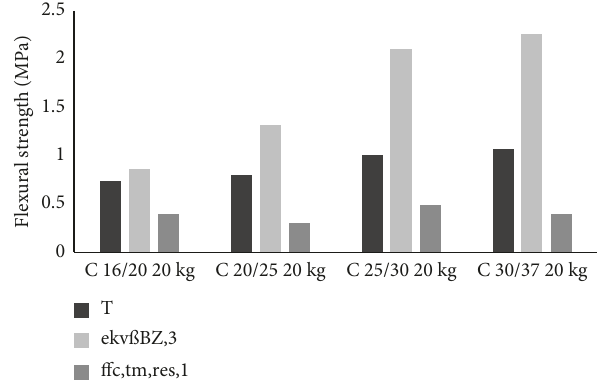
Figure 9: Residual tensile strengths in bending at the moment of achieving a deflection of 3.5mm, steel fiber reinforced concrete with a dose weight of 30kg/m 3